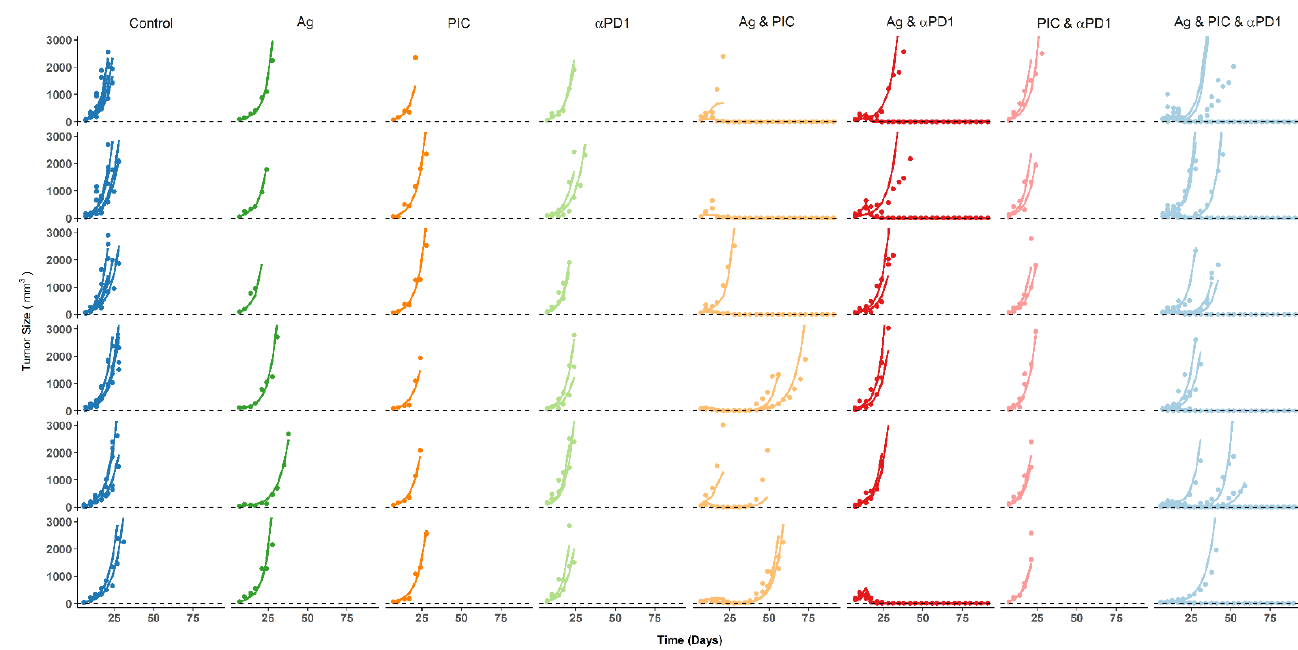
Figure 4. Individual model predictions. Tumor size observations (points) and individual model predictions (lines) for all the treatment groups included in the analysis. 4 mm 3 was considered as the limit of quantification (dashed lines). For those treatment groups with a higher number of animals, more than one TS profile was included in each panel.